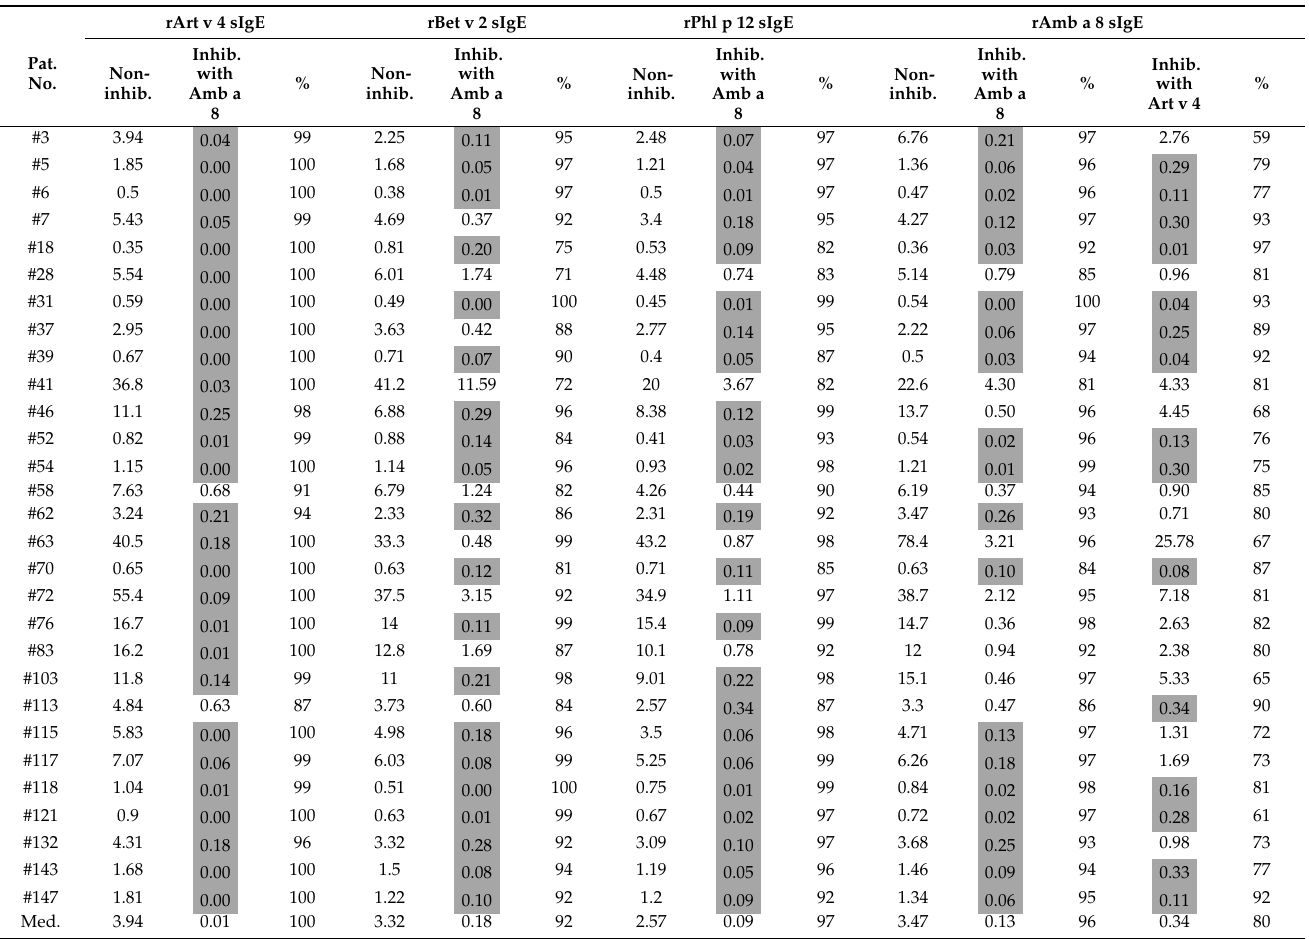
Table 3. Inhibition of allergic patients’ IgE binding to profilins rAmb a 8 (ragweed), rArt v 4 (mugwort), rBet v 2 (birch) and rPhl p 12 (timothy grass) by serum pre-incubation with Amb a 8 and inhibition of IgE binding to Amb a 8 by Art v